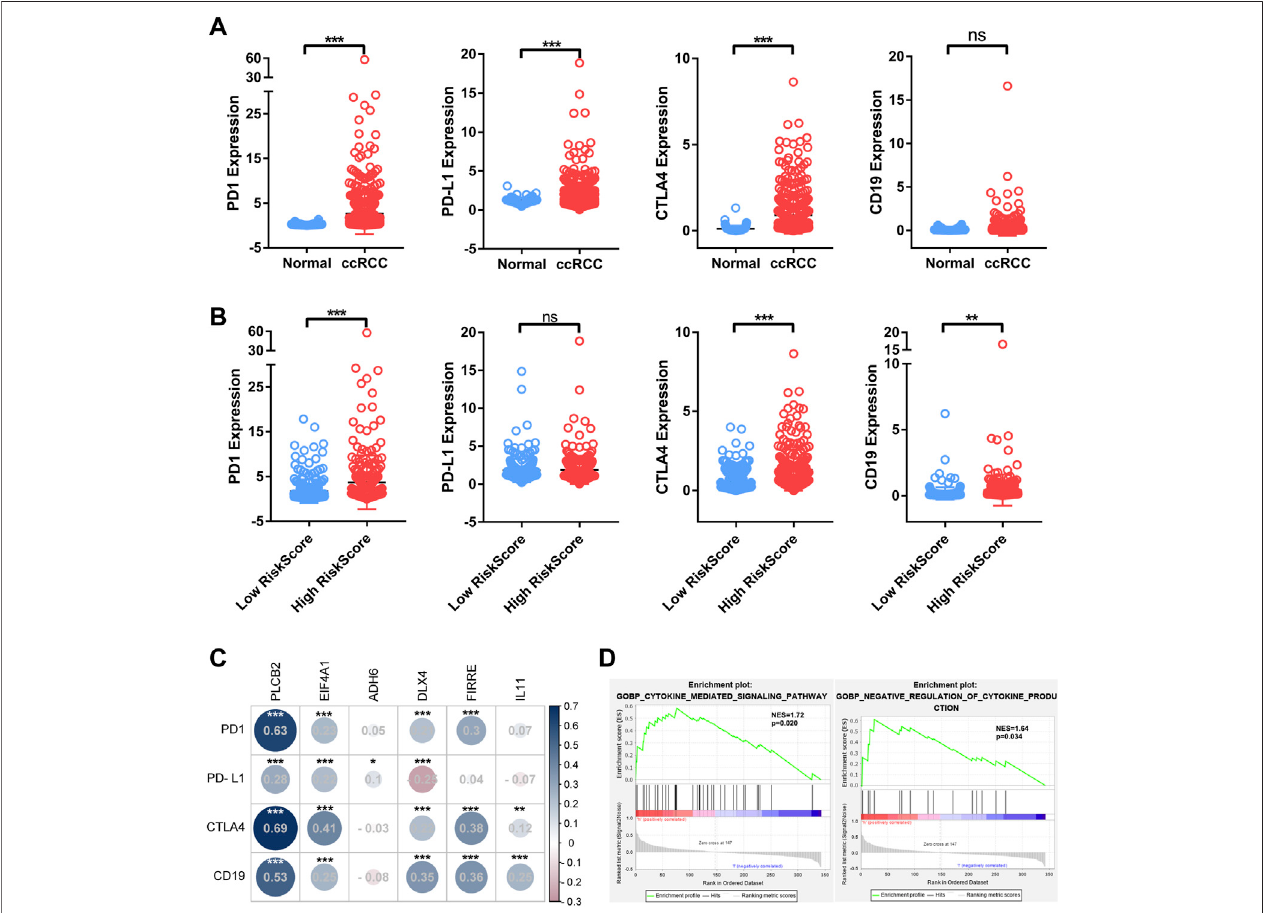
FIGURE7 | Associationoffour immuno-oncology targets withBu-Meta-GPS in ccRCC. (A) Expression level of PD-1 , PD-L1 , CTLA4 , and CD19 in ccRCC tissues andnormalrenaltissues. (B) Expressionlevelof PD-1 , PD-L1 , CTLA4 ,and CD19 inhigh-andlow-riskscoregroups. (C) CorrelationofBu-Meta-GPSwith PD-1 , PD-L1 , CTLA4 , and CD19 in ccRCC. (D) GSEA showed that the cytokine-mediated signaling pathway was differentially enriched in the high-risk group (NES, normalized ES; * p < 0.05; ** p < 0.01; *** p < 0.001; ns, not statistically signi fi cant).